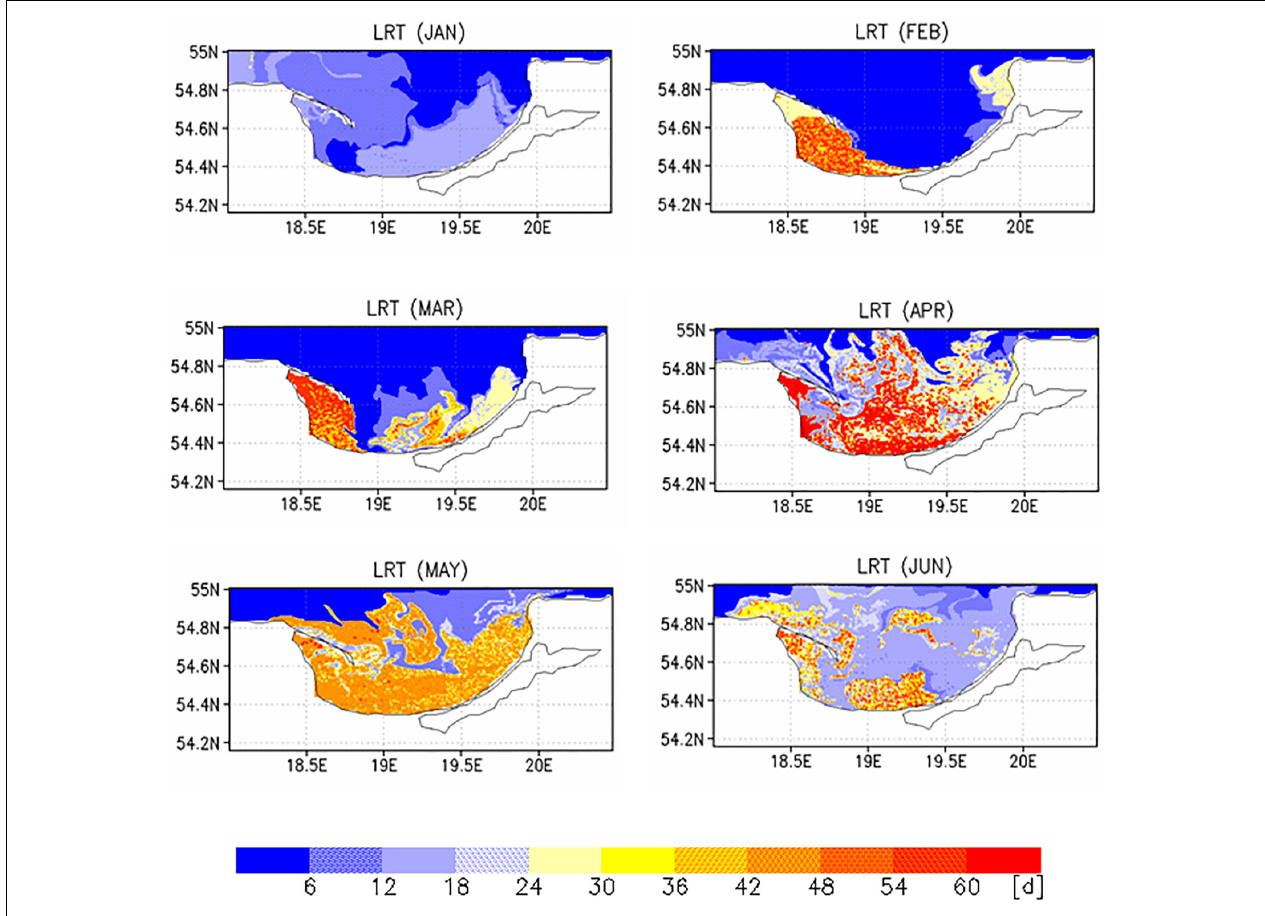
FIGURE 6 | Lagrangian residence time (LRT) in days for January to June 2009.